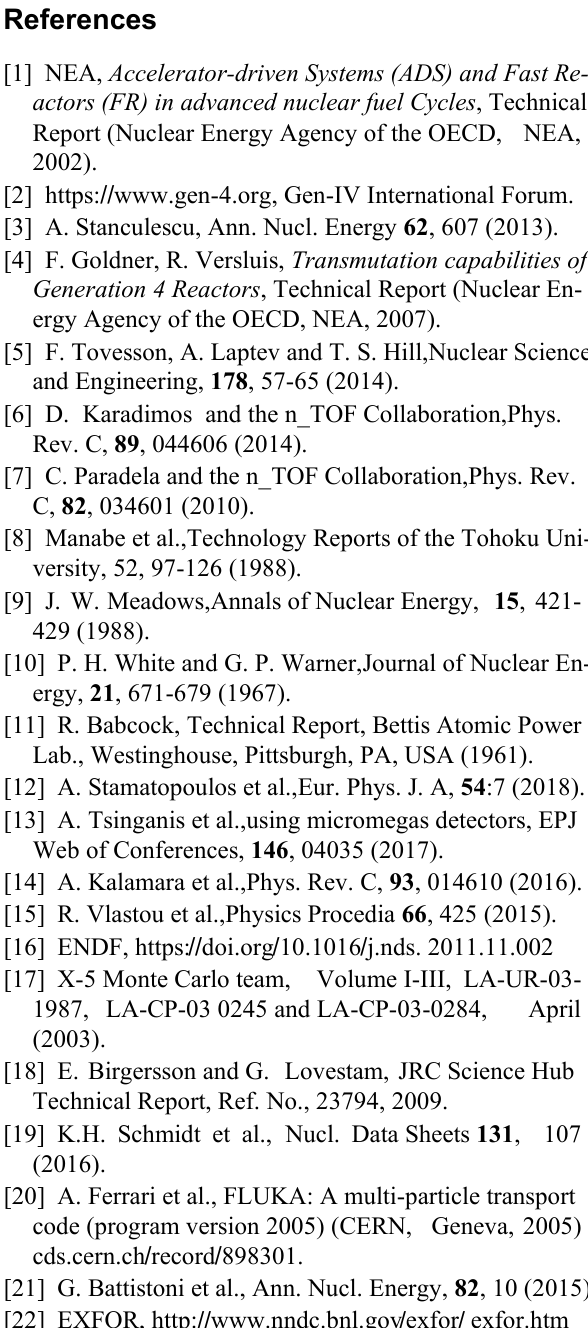
Table 3. Experimental cross section values and uncertainties obtained from the present work for the 234 U(n,f) reaction.